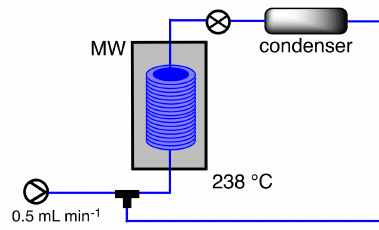
Figure 4. Microwave-assisted cyclic continuous flow oligomerization of